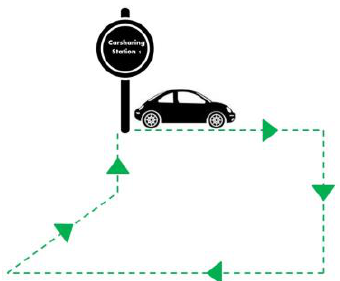
Figure 1. Carsharing station-based round-trip (Source: Authors) The station-based one-way modality is similar to the previous one, but in the unidirectional case, the station where the trip ends may be different from the station where it started (see Figure 2). The set of parking lots (stations) is predefined (Ferrero et al., 2018).